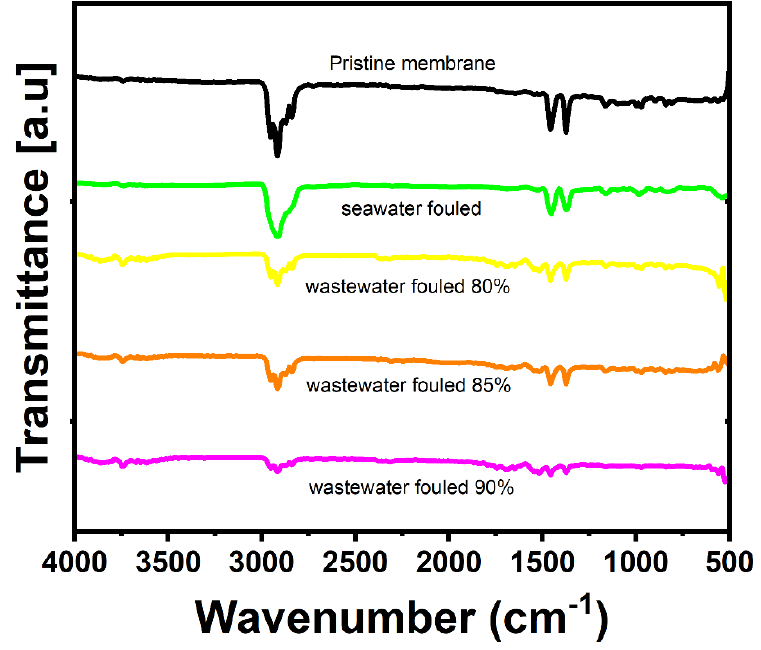
Figure 9. FT-IR bands of pristine and fouled membranes by seawater and wastewater at different recoveries.